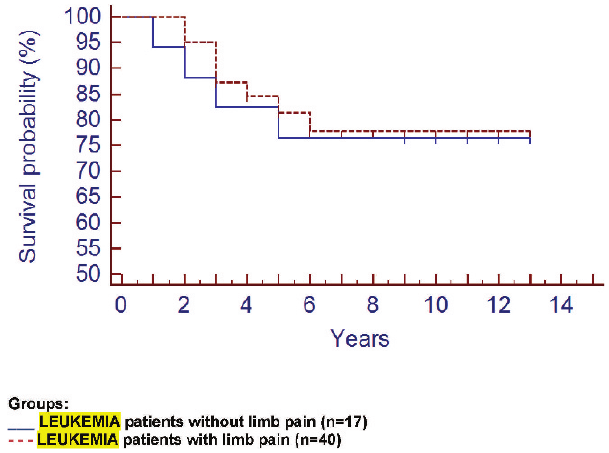
Figure 1 - The Kaplan-Meier overall survival curves between leukemia patients without (n = 17) and with limb pain (n=40) ( p =0.8322).